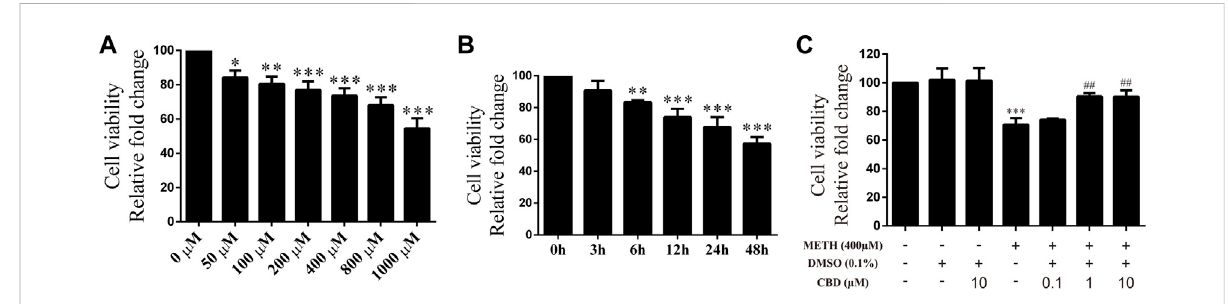
FIGURE 2 Cellviabilityofneuronsincubatedwithdifferentdrugs. (A) CellviabilityofneuronsincubatedwithMETHfor24 hatdifferentconcentrations(50, 100, 200, 400, 800, and 1,000 μ M). (B) Cell viability of neurons incubated with 400 μ M METH at different time points (3, 6, 12, 24, and 48 h). (C) Cell viability of neurons incubated with CBD (0.1, 1, and 10 μ M) and/or METH (400 μ M). * p < 0.05, ** p < 0.01, or *** p < 0.001 compared with control group, ## p < 0.01 compared with METH group; Tukey HSD post-hoc comparison after signi fi cant